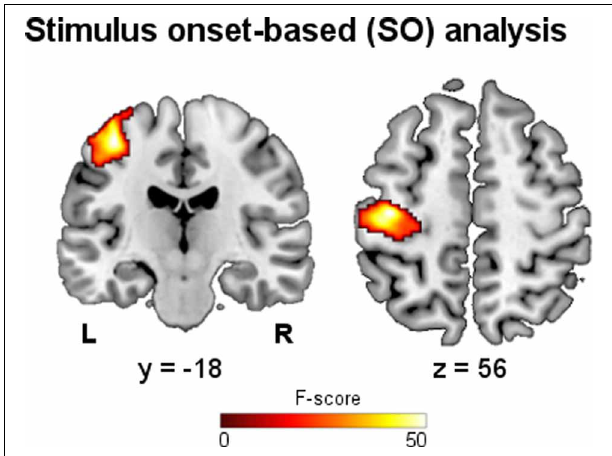
FIGURE 2 | Stimulus onset-based analysis. Group map showing the main effect of right hand grip on fMRI data ( p < 0 . 05, FWE).